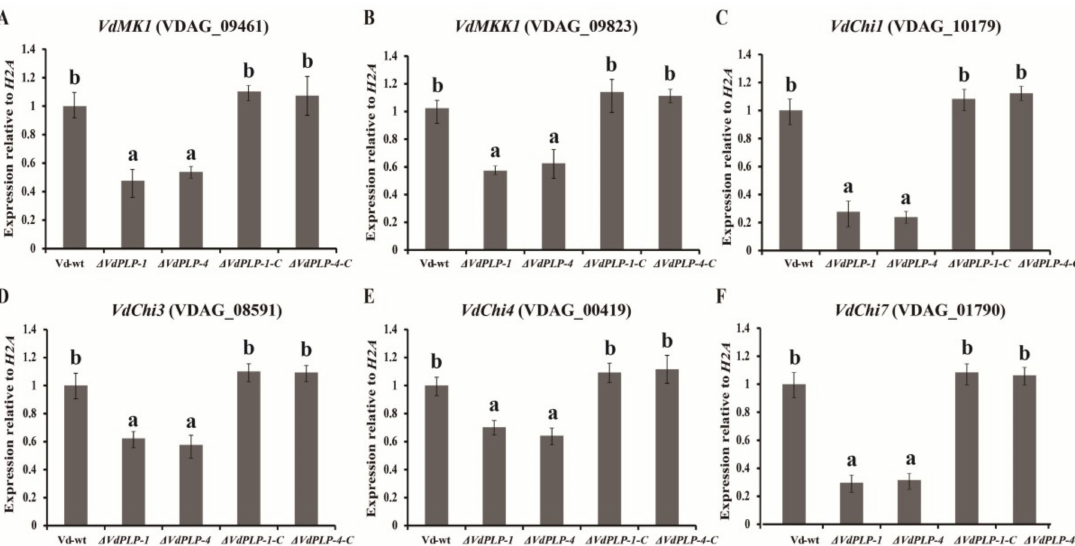
Figure 5. Expression of cell wall integrity (CWI) pathway genes ( VdMKK1 (VDAG_09823) and VdMK1 (VDAG_09461)), and chitin synthesis genes ( VdChi1 (VDAG_10179), VdChi3 (VDAG_08591), VdChi4 (VDAG_00419) and VdChi7 (VDAG_01790)) in the ∆ VdPLP mutant strains ( ∆ VdPLP-1